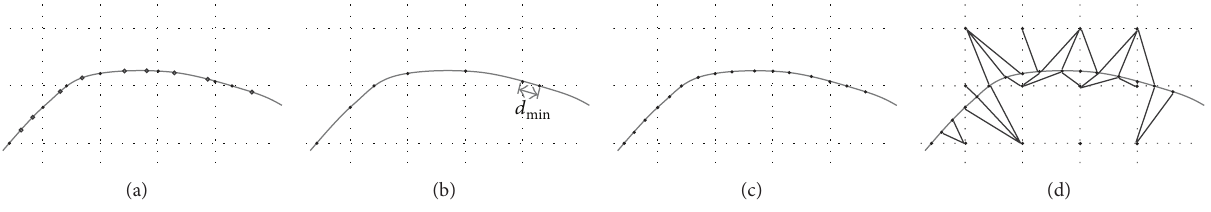
algorithm searches for the continuous two points 𝑃 1 and 𝑃